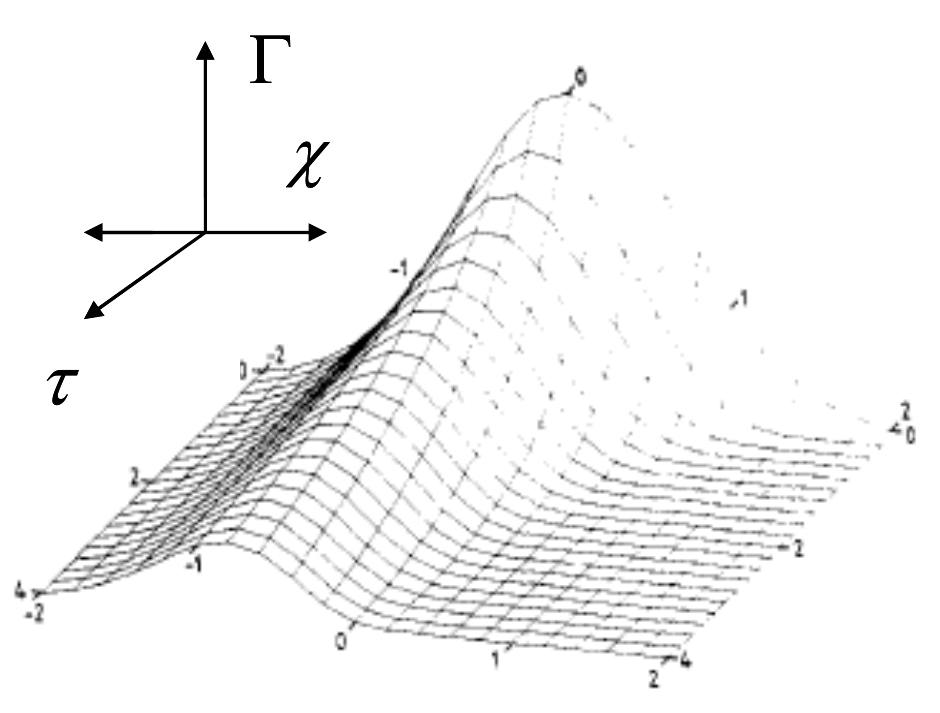
Figure 21. The decay of the Gaussian population calculated using eqn.51 with spread parameter γ = 2.